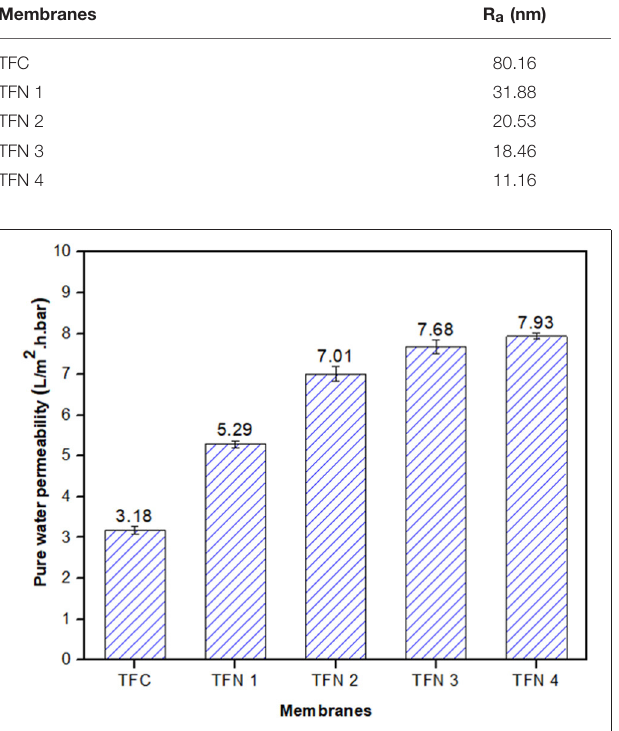
FIGURE 7 | Water permeability of TFC and TFN membranes.